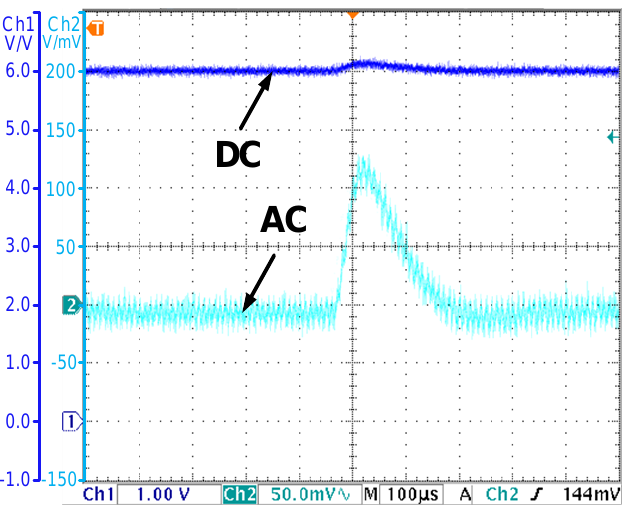
Figure 12. The output voltage transient when the input voltage steps from 10 to 12 V—a conventional voltage mode controlled converter.